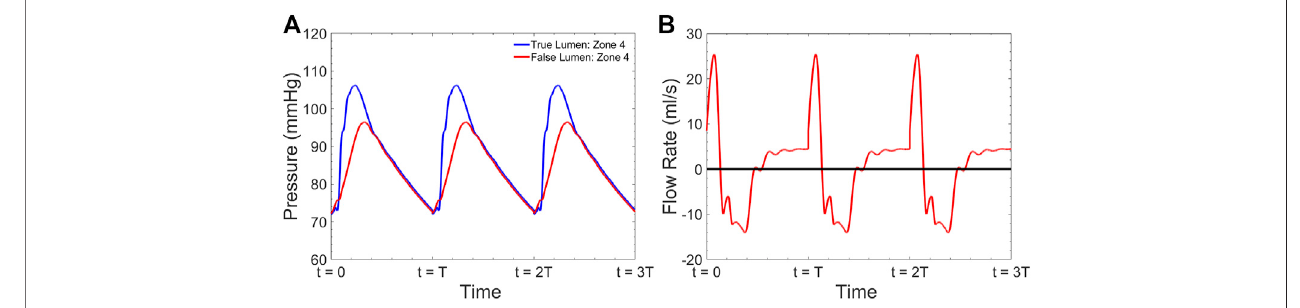
FIGURE 6 | Simulated (A) pressure inside the TL and FL at zone 4 and (B) fl ow inside the FL at zone 4 for λ = 0.66 and HR = 60 bpm.